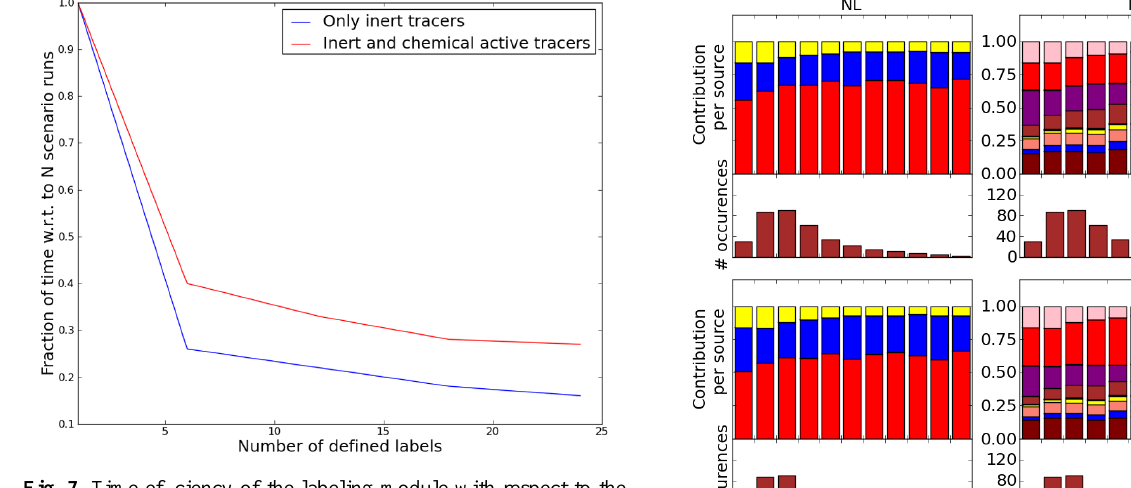
Fig. 7. Time efficiency of the labeling module with respect to the scenario approach. On the x-axis the number of labels (sources of interest) defined. On the y-axis the relative fraction of computation time with respect to the total computation time of all needed scenar- ios run (for each source of interest a separate scenario run).